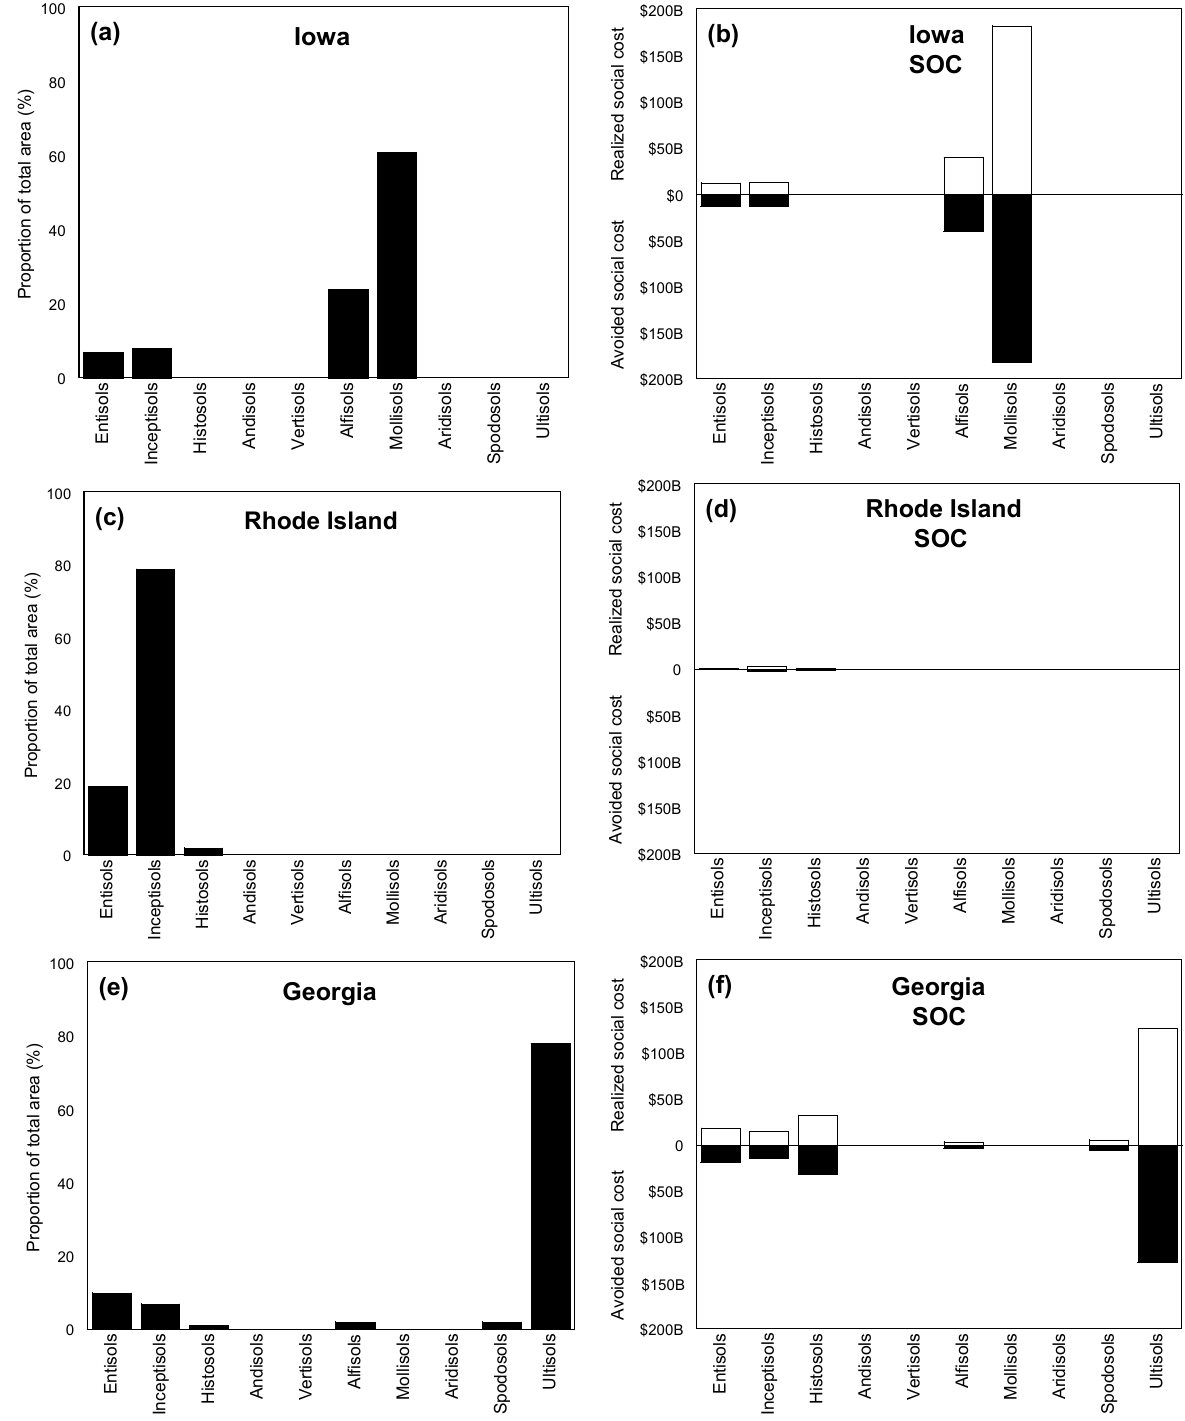
Figure 12. Diagram showing how the “portfolio effect” and the “distribution effect” of pedodiversity can vary by state: ( a , c , e ) pedodiversity by soil order area; ( b , d , f ) value of soil organic carbon (SOC) storage in the upper 2 m depth based on avoided or realized social cost of CO 2 (SC-CO 2 ) of $42 (USD) per metric ton of CO 2 [35,51] by soil order. Note: B = billion = 10 9